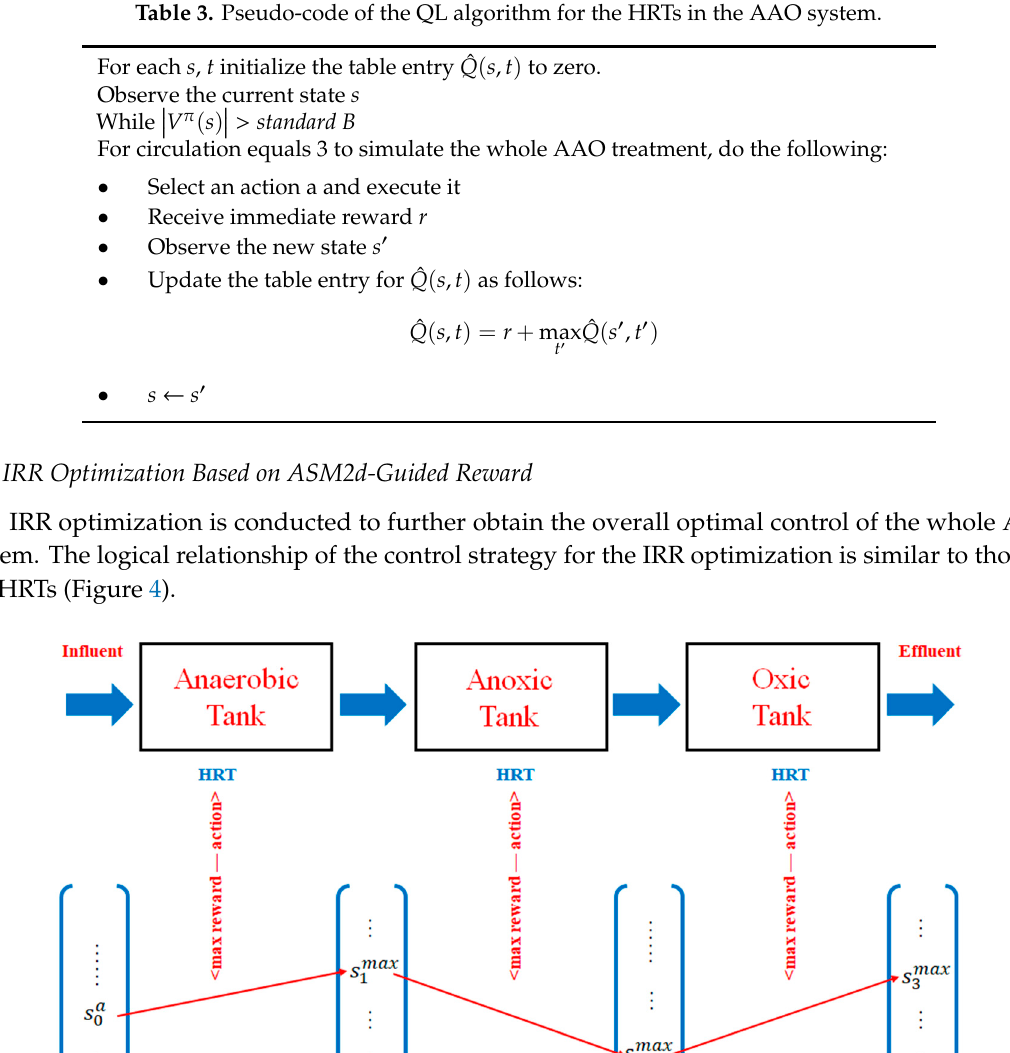
Figure 5. Simplified mapping function for IRR optimization in AAO system by an integrated ASM- QL algorithm. 4.2. Model Validation Experiments and simulation analyses based on eight continuous-flow AAO systems operated under different influent loads (Table 1) were conducted to validate the proposed integrated ASM-QL algorithm. By conducting the iterated and updated optimization of the HRTs through the ASM-QL algorithm, the step length of the control parameters of the HRTs under different reaction tanks in